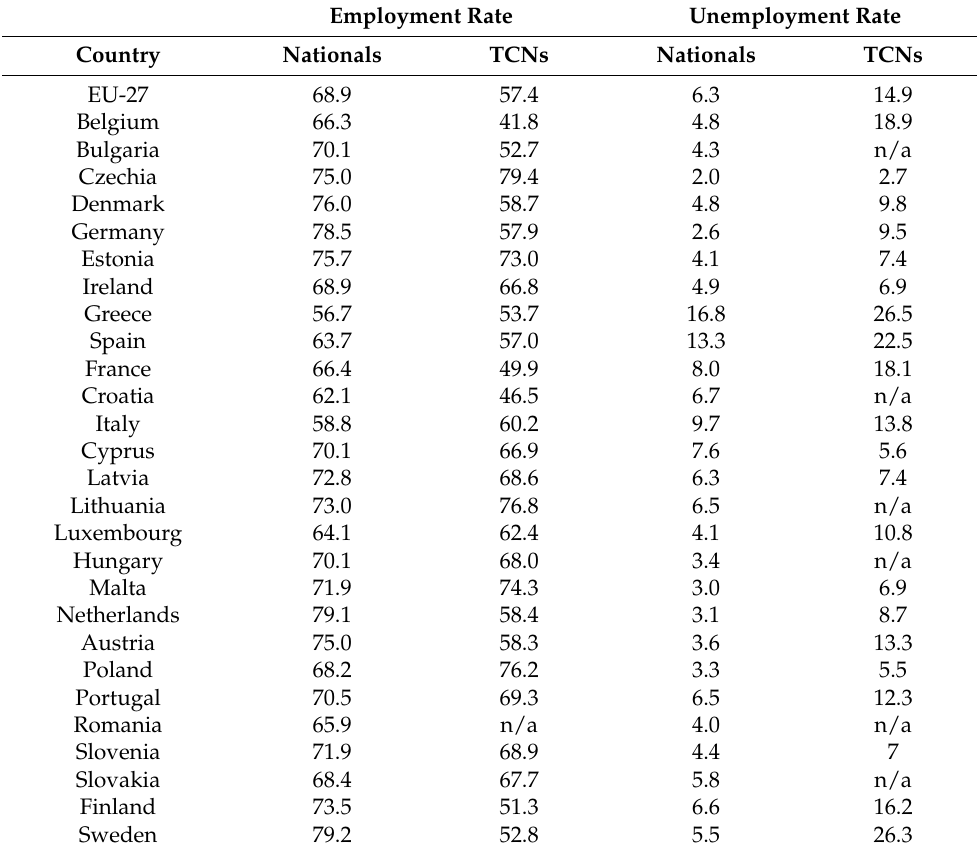
Table 1. Employment and unemployment rate (age 15–64) of nationals and third-country nationals (TCNs) in each Member State in 2019 (the table is structured by authors upon open-source data collected from